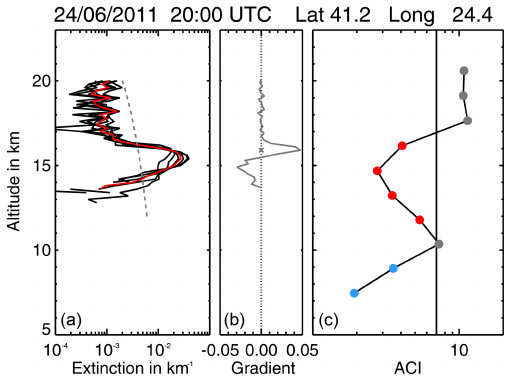
Figure 5. Nabro sulfate aerosol layer measured by CALIOP and MIPAS. (a) The red line is the averaged lidar profile of the in- dividual lidar profiles within the match range (black lines). The grey dashed line indicates the altitude-variable extinction coefficient threshold of 3 × 10 − 3 km − 1 at 18km used to estimate the top height of the aerosol layer (Winker et al., 2009). (b) The gradient of the averaged lidar profile, where the cross at the maximum gradient in- dicates the top height according to the gradient method described by Mattis et al. (2008). (c) MIPAS ACI profile. The dots mark the tan- gent altitudes, where grey dots indicate clear air, red dots aerosol, and blue dots ice clouds. The black solid line marks the ACI detec- tion threshold of